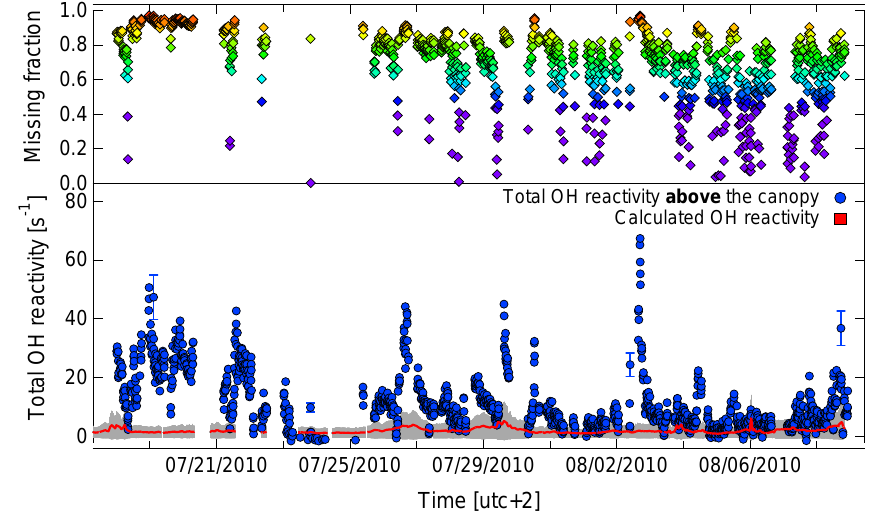
Fig. 3. Overview of total OH reactivity measurements above the canopy (blue markers), calculated OH reactivity (red) and superimposed the missing fraction of total OH reactivity (color-coded by itself). High missing fraction indicates a high percentage of unaccounted for OH reactivity when comparing single compound ambient measurements to the results of CRM. Error bars in grey show the uncertainty in the total OH reactivity calculation. Table 3. Characteristic regimes during HUMPPA-COPEC 2010, average values for total OH reactivity measured in the canopy (18m) and above the canopy (24m), the mean in canopy – above the canopy comparison 0 , average calculated and missing OH reactivity and the average missing fraction of total OH reactivity. Uncertainties are given as standard